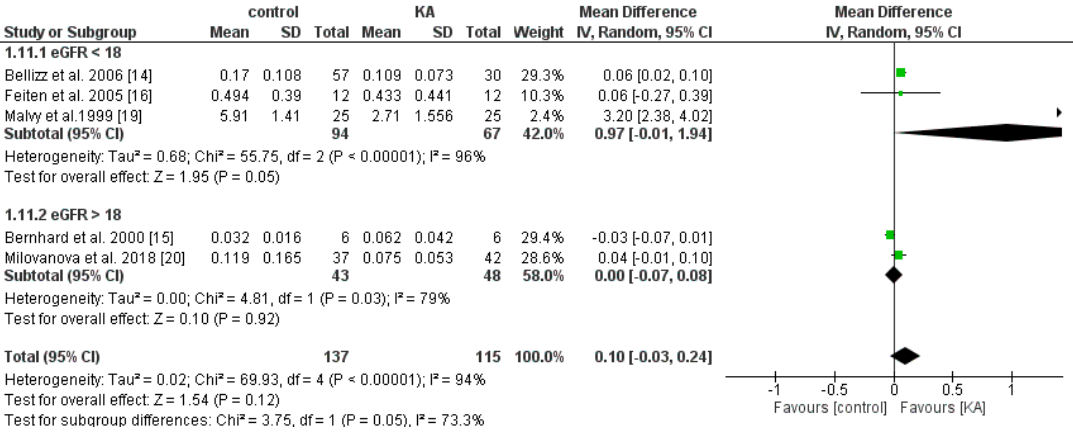
Figure 12. Forest plot of effects of KA on parathyroid hormone (PTH) in CKD patients sub-grouped by eGFR. The random-effects model was utilized.